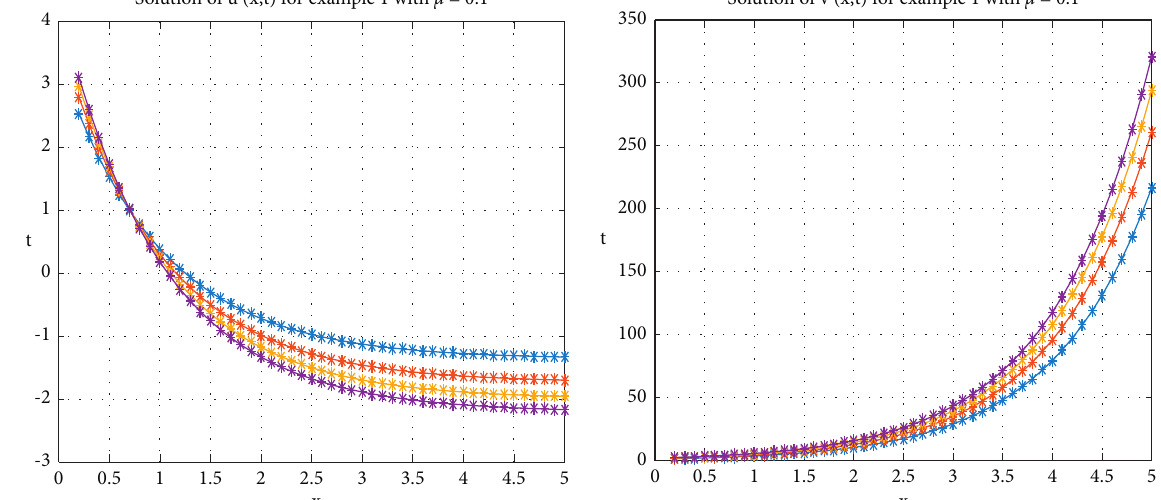
Figure 1: 2D graphical representation for u ( t, x ) and v ( t, x ) of equation (9).